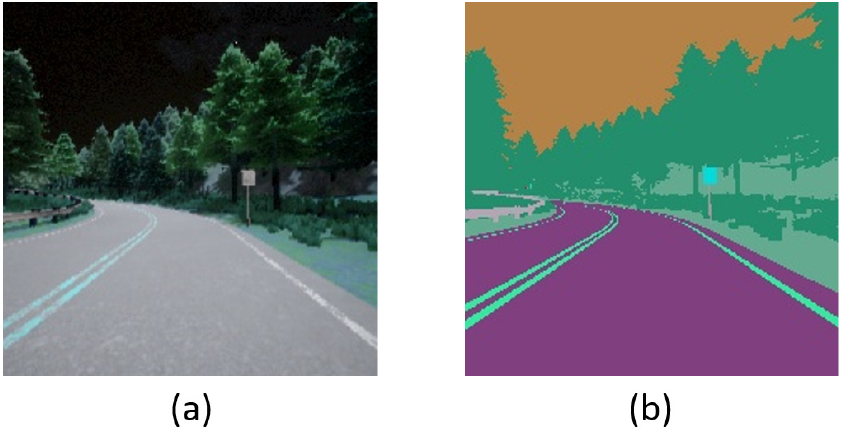
Figure 1. An example of driving vision: ( a ) RGB camera; ( b ) Semantic segmentation